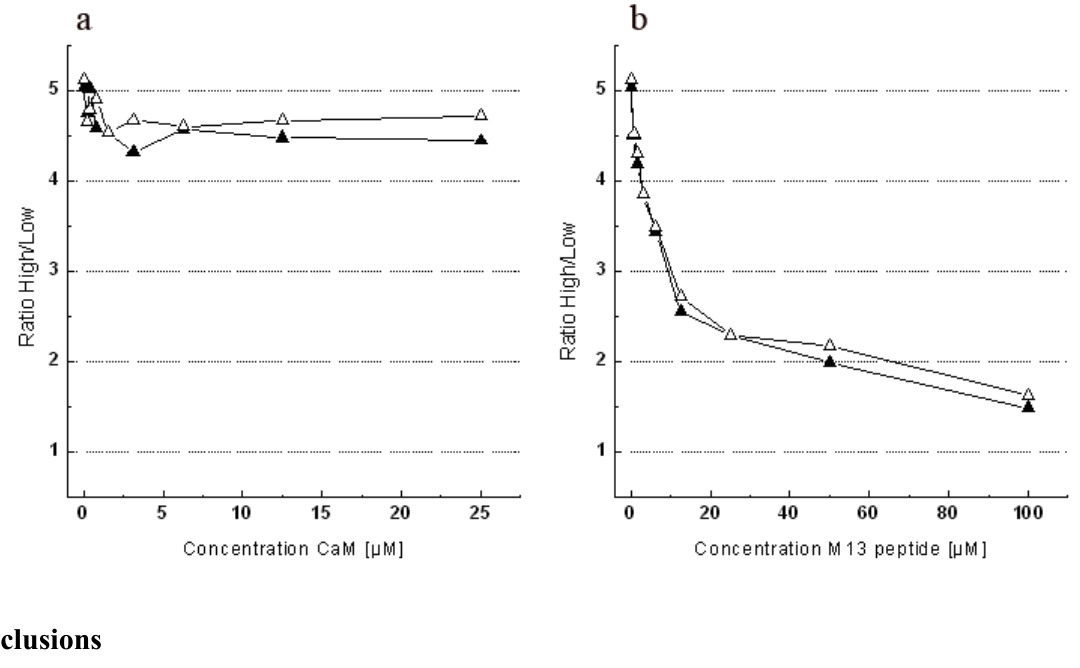
Figure 5. Titration experiments of Case12 and Case16 with free M13-peptide and CaM. (a) The titration of Case12 and Case16 with free CaM. (b) The titration of Case12 and Case16 with free M13-peptide. Filled symbols correspond to the values obtained for Case12 and open symbols for